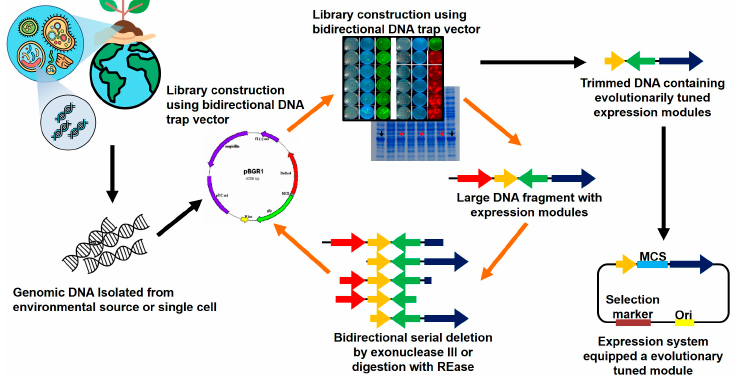
Figure 1. Schematic representation of the screening and trimming of expression modules from the metagenomics DNA library. During the procedure, a promoter or promoter-like signal-trap vector equipped with a bi-directional reporter system was employed. Trimming of screened DNA fragments was conducted by specific deletion or serial deletion using restriction enzymes or exonuclease III according to the general procedure. Functional analyses of reporter expression by trimmed DNA containing the promoter or promoter-like signal was monitored by UV excitation and further confirmed by expression level using